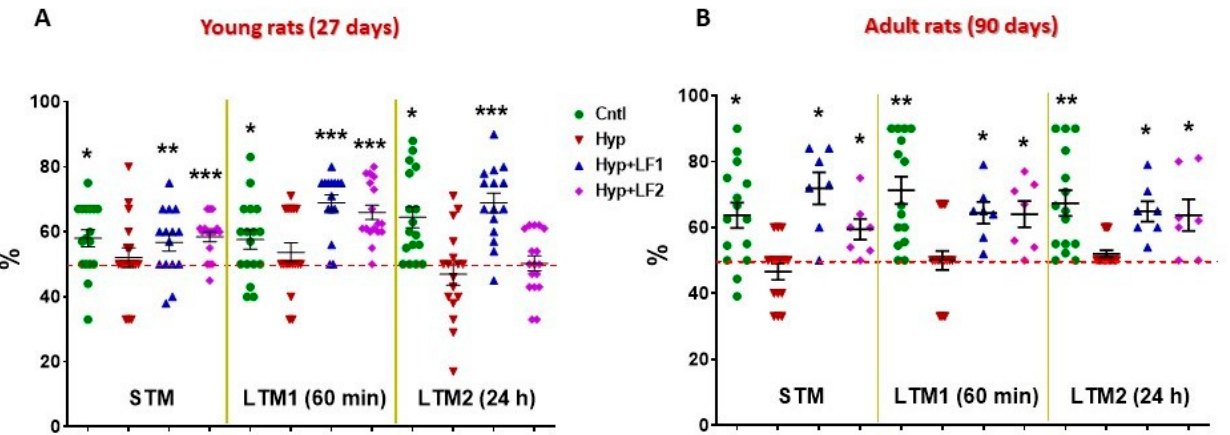
Figure 4. Results of testing short-term memory (STM) and long-term memory (LTM1 and LTM2) in the offspring of hypoxia-treated rats by Novel Object Recognition test. Ordinate: mean ± SEM of the time spent exploring novel objects expressed in % of the total time spent exploring both the novel and familiar objects. ( A )—Rats tested on postnatal day 22; ( B )—Rats tested on postnatal day 90. *— p ≤ 0.05; **— p ≤ 0.01; ***— p ≤ 0.01 (one sample test) differences between the time spent exploring the